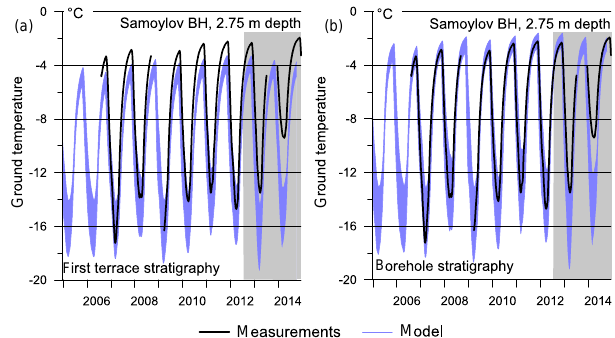
Figure 8. Modeled and measured ground temperatures for the bore- hole on Samoylov Island. (a) Subsurface stratigraphy of the first terrace (Table 1). (b) Stratigraphy adapted to the true ground condi- tions at the borehole (0–0.5m: 30% water/ice, 10% air, 60% min- eral, sand; 0.5–9m: 40% water/ice, 60% mineral, sand; deeper lay- ers as for first terrace, Sect. 4.2.1). The blue area depicts the spread between model runs with snow densities of 200 and 250kgm − 3 . Periods for which in situ data are affected by new installations at the Samoylov station are marked in grey. These should not be used for comparison, see